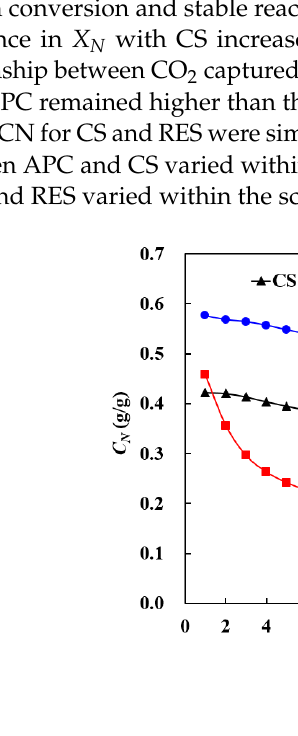
Pore Width /nm APC RES CS Figure 4. Pore size distribution of samples. Table 3. Surface and pore structure statistics of samples measured from N 2 absorption. Samples